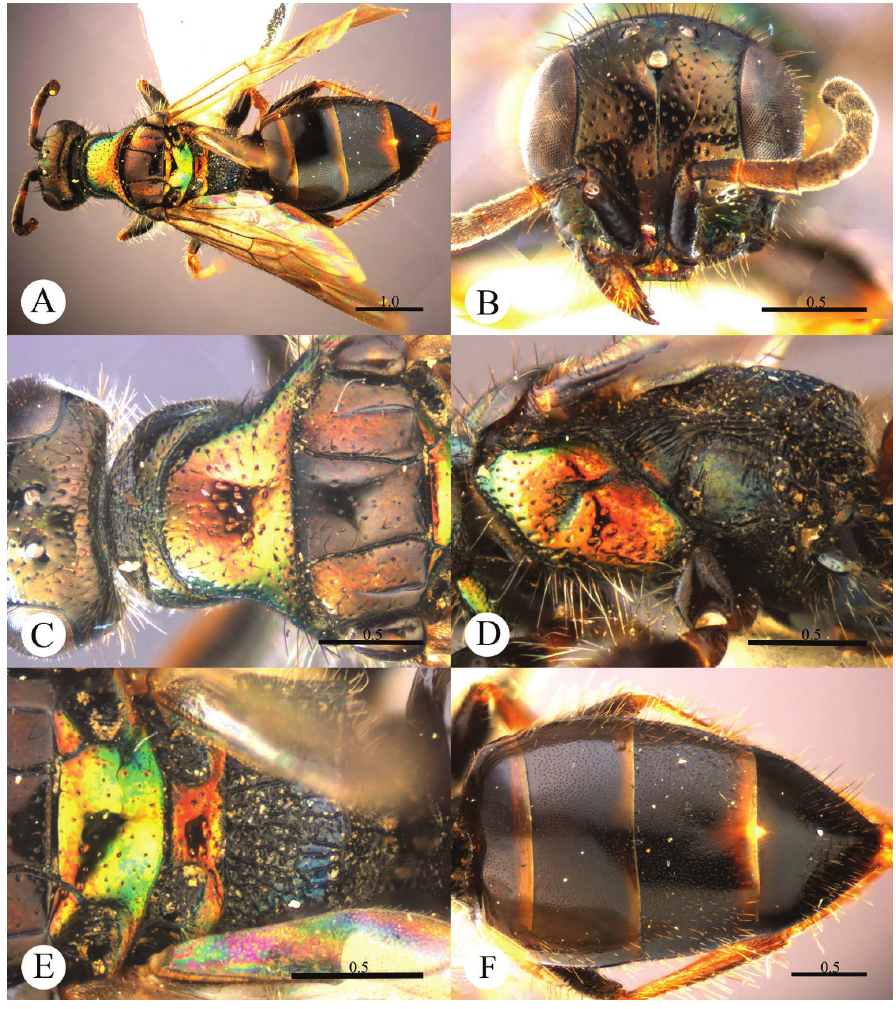
Plate 4. Cleptes helanshanus sp. n., holotype, female. A Habitus dorsal B Head anterior C Head, pronotum and mesoscutum dorsal D Mesopleuron and metapleuron lateral e Mesoscutellum, metano- tum and propodeum dorsal F Metasoma dorsal. Scale bars in Diagnosis. This species resembles C. mareki Rosa based on the pronotum without posterior pit row and metanotum without pit or fovea. However, C. helanshanus sp. n. can be quickly separated from this species by the colouration: pronotum golden, laterally with green tints, mesopleuron and metanotum golden red, and mesoscutellum greenish-golden. Description. Female. Holotype. Body length 5.9 mm (Plate 4A). Forewing length 3.9 mm. HW : HH : HL = 79 : 81 : 38. POL : OOL : OCL = 10 : 13 : 18. MS = 1.7 MOD. Width of clypeal lower margin = 1.7 ASD. L/W of Ped, F-I, F-II, and F-III are 2.1, 2.1, 1.2, and 1.0, respectively.